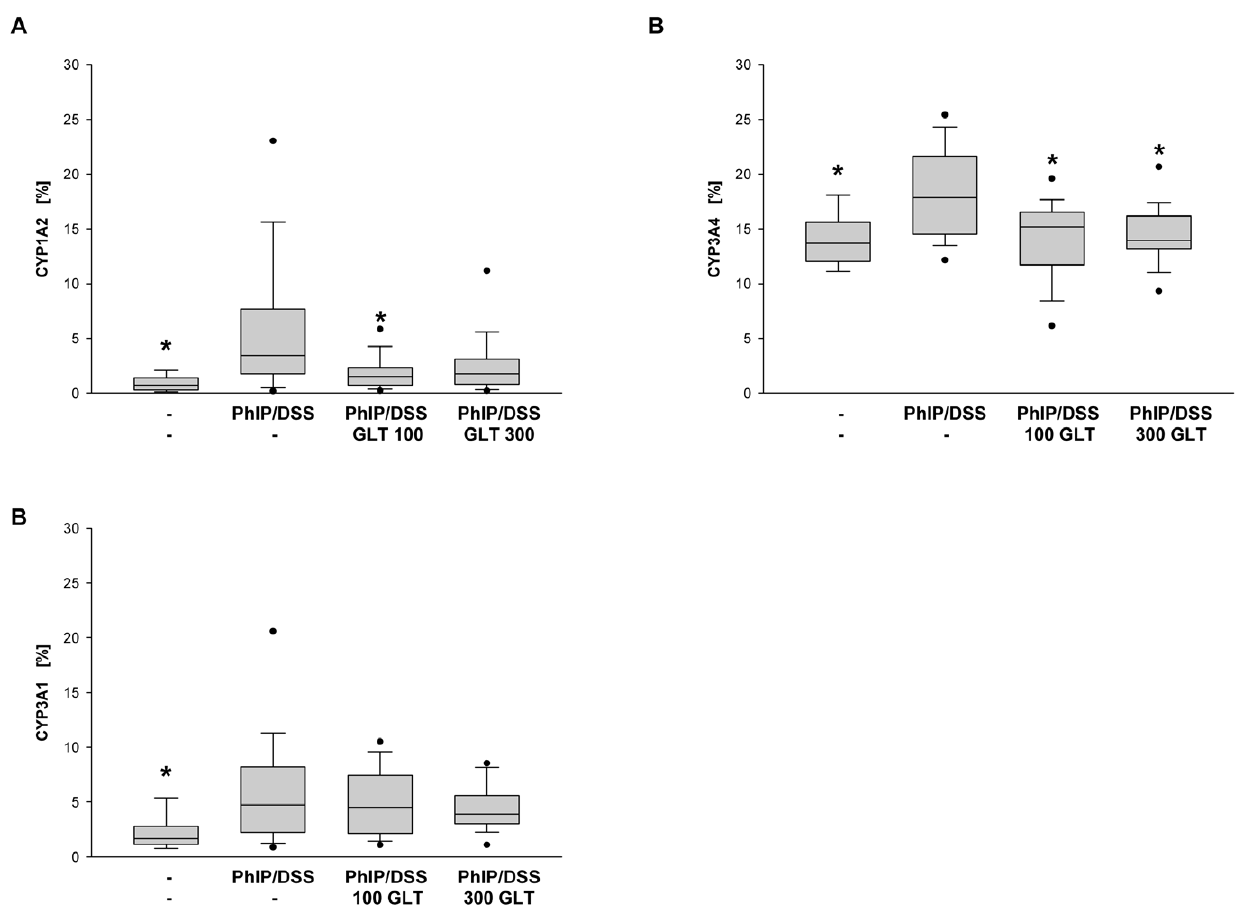
Figure 7. Effect of GLT on PhIP/DSS-induced expression of CYP1A2, CYP3A4 and CYP3A1 in colon tissue. Quantification of (A) CY1A2, (B) CYP3A4, and (C) CYP 3A1 positive cells as described in Materials and Methods . Box plots represent 5 th /10 th percentiles, horizontal bars represent median values, and whiskers indicate minimum to maximum values. Significant differences (*p , 0.05) were observed among (A) CYP1A2: PhIP/DSS vs. control, PhIP/DSS vs PhIP/DSS + GLT 100 (B) CYP3A4: PhIP/DSS vs. control, PhIP/DSS vs PhIP/DSS + GLT 100, and PhIP/DSS vs. PhIP/DSS + GLT 100, and (C) CYP3A1: PhIP/DSS vs. control.